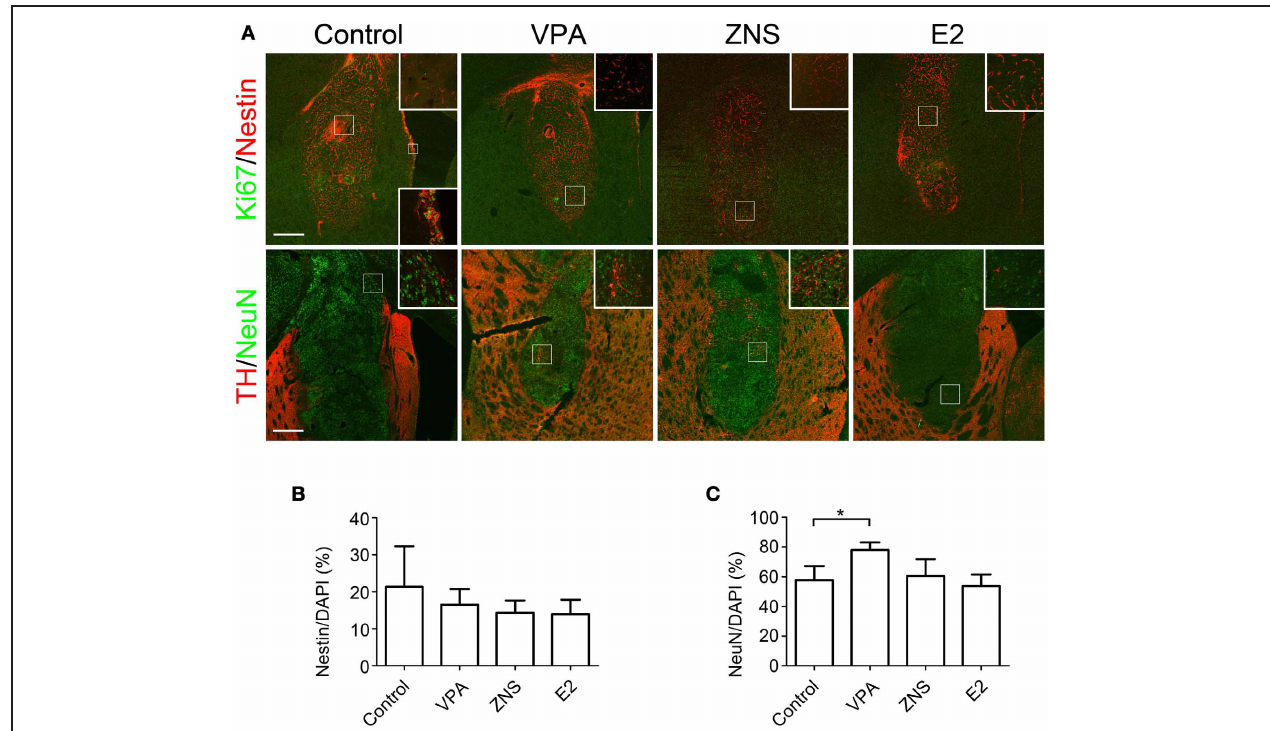
the inlet. The lower inlet displays a high magnification of the proliferating neural precursors lining the ventricular surface as a positive control for Ki67 staining. The scale bar applies to all pictures and represents 500 μ m. A comparison between each group for (B) the number of Nestin + cells per the total number of cells in the graft, (C) the number of NeuN + cells per the total number of cells in the graft. The data are presented as the mean ± SD. ( ∗ P < 0 . 05; n = 8 control, n = 6 VPA, ZNS,